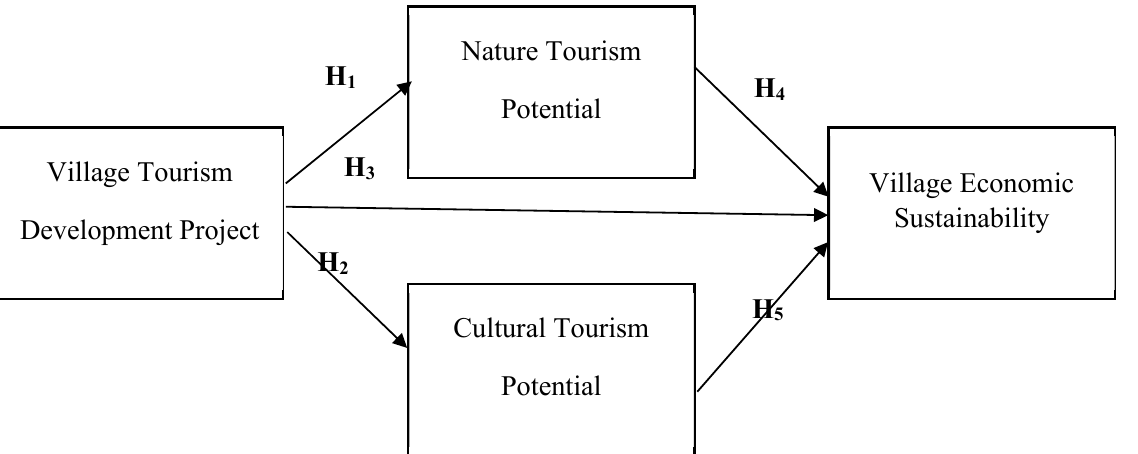
Fig. 1. The Research Model of the Village Tourism Development